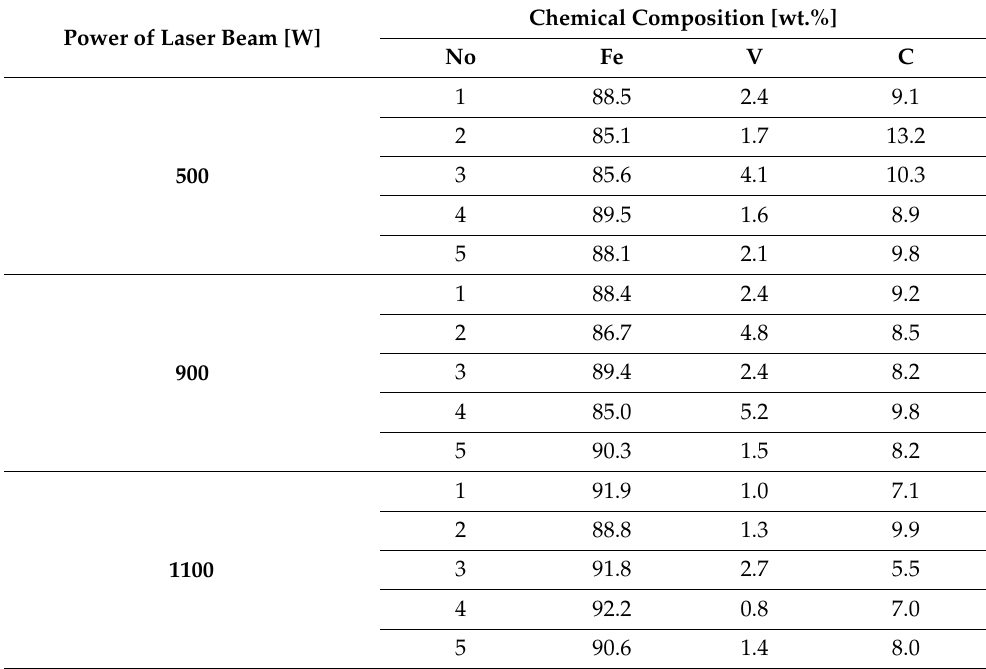
Table 3. Chemical composition (EDS) in the central part of the remelted zone of laser tracks after laser processing with VC (wt.%). Chemical Composition Power of Laser Beam [W]